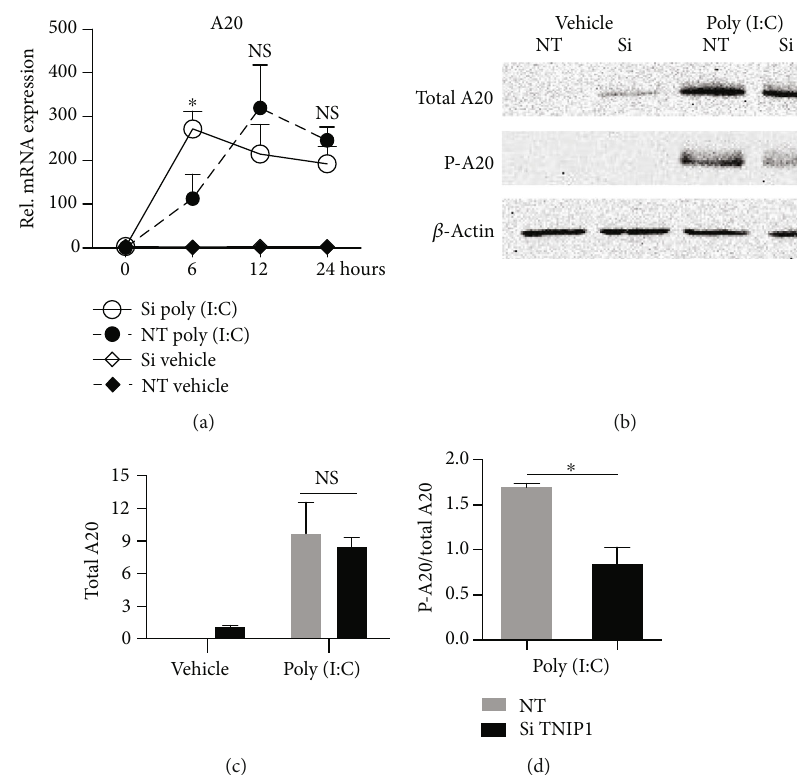
Figure 5: A20 phosphorylation is decreased in cells with reduced TNIP1. (a) Gene expression analysis at 6, 12, and 24 hours post-poly (I:C) (1 μ g/mL) exposure of HaCaT keratinocytes transfected with TNIP1 siRNA (Si) or nontargeting control (NT). qRT-PCR was analyzed by the delta-delta Ct method after normalization to RPL13a. (b) Representative western blot analysis of total and phosphorylated A20 (P-A20) 24hr post-poly (I:C) (1 μ g/mL) exposure. (c) Densitometry analysis of total A20 and (d) the ratio of phosphorylated A20 to total A20. 15 μ g were loaded per sample and normalized to β -actin. Statistical analysis was performed using two-way ANOVA followed by Bonferroni ’ s post hoc test for (a) with ( ∗ ) or NS, representing comparison of NT poly (I:C) and Si poly (I:C). Student ’ s t -test was used for analysis in (c) and (d). Data is presented as mean + SEM from two independent experiments with conditions in each set in triplicate. Asterisk ( ∗ ) represents statistically signi fi cant di ff erence ( ∗ p value of ≤ 0.05; NS: nonsigni fi